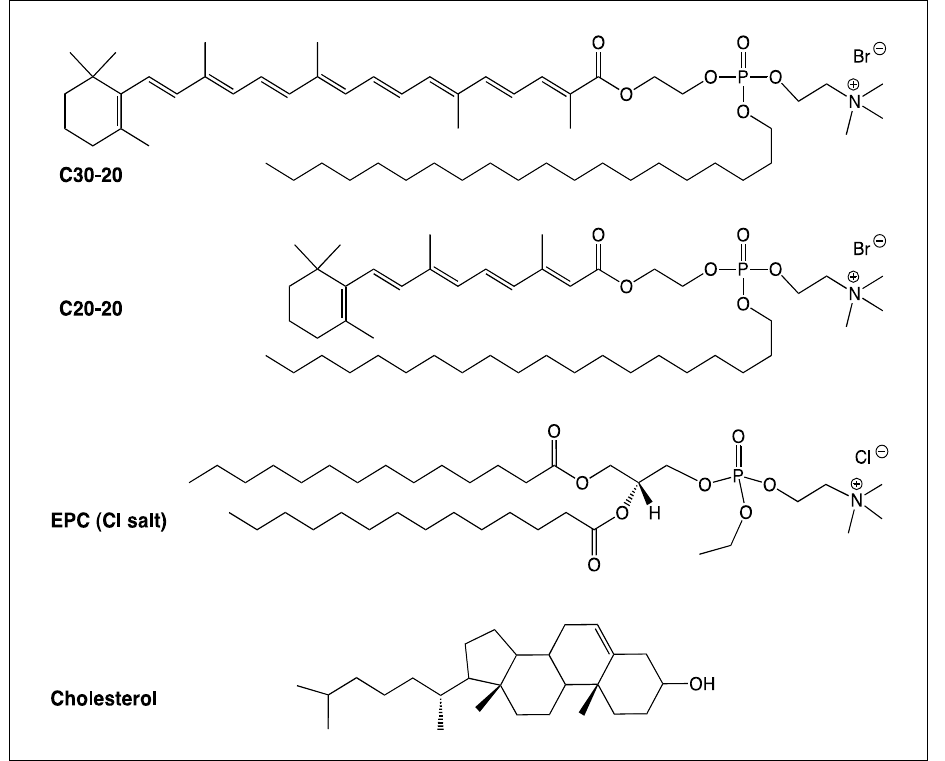
Figure 1. Structures of cationic carotenoid lipids C30-20 and C20-20, together with commercially available cationic lipid EPC, and neutral co-lipid,